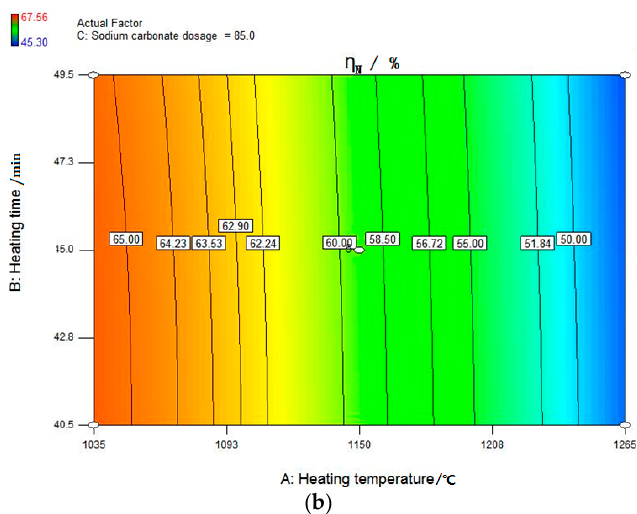
Figure 4. ( a ) Response surface of heating temperature–heating time plot; ( b ) contour of heating temperature–heating time plot.